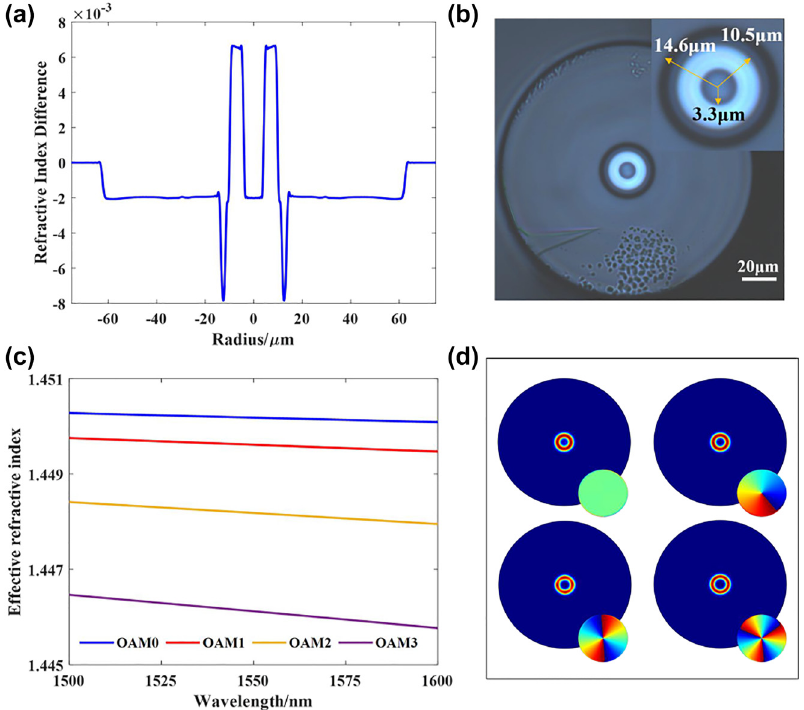
Figure 3: The relative parameters of ring-core fiber. (a) The refractive index profile; (b) the end face image of RCF; (c) the dispersion curve of RCF; (d) OAM modes profile supported by the